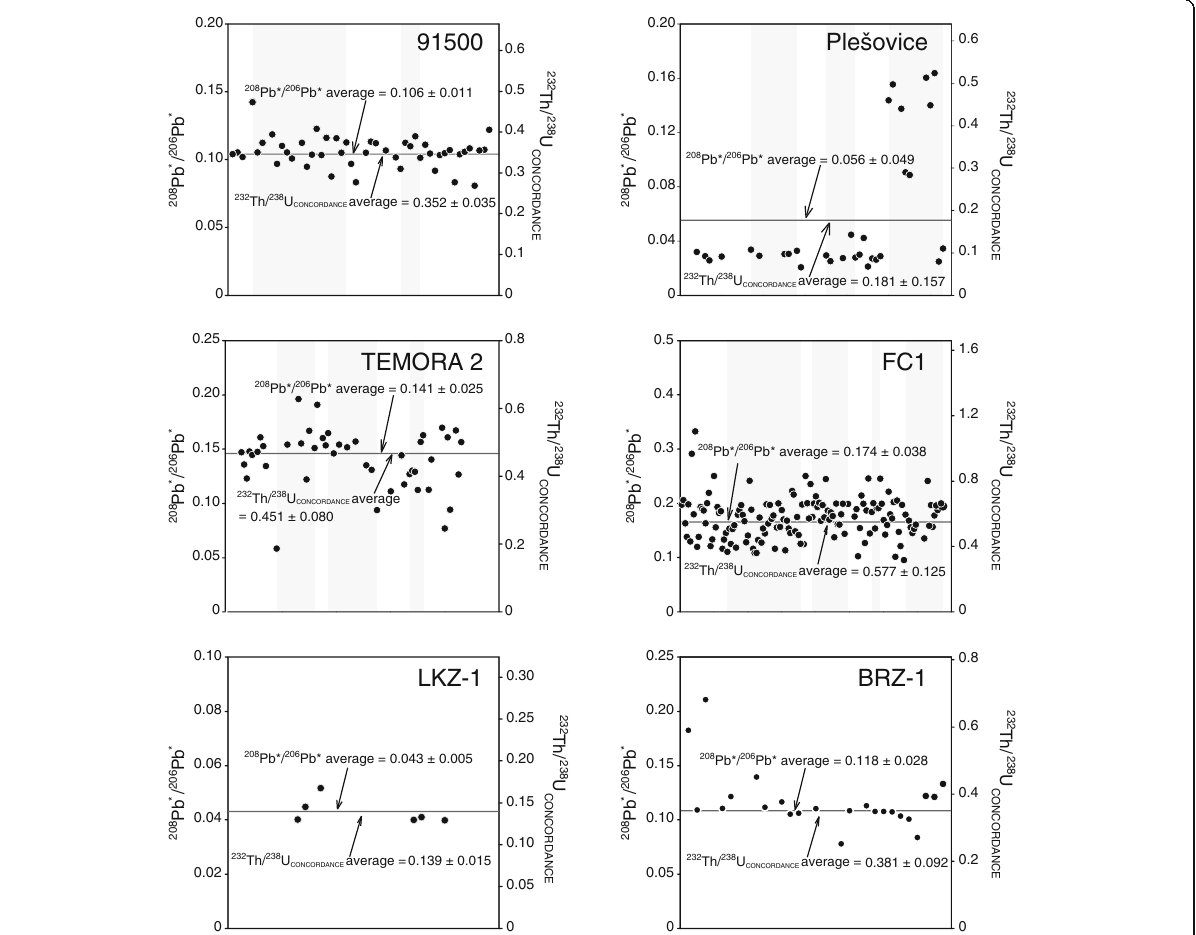
Fig. 2 The SHRIMP 208 Pb/ 206 Pb and calculated 232 Th/ 238 U CONCORDANCE for the zircons. Each analytical session is marked in shaded and unshaded